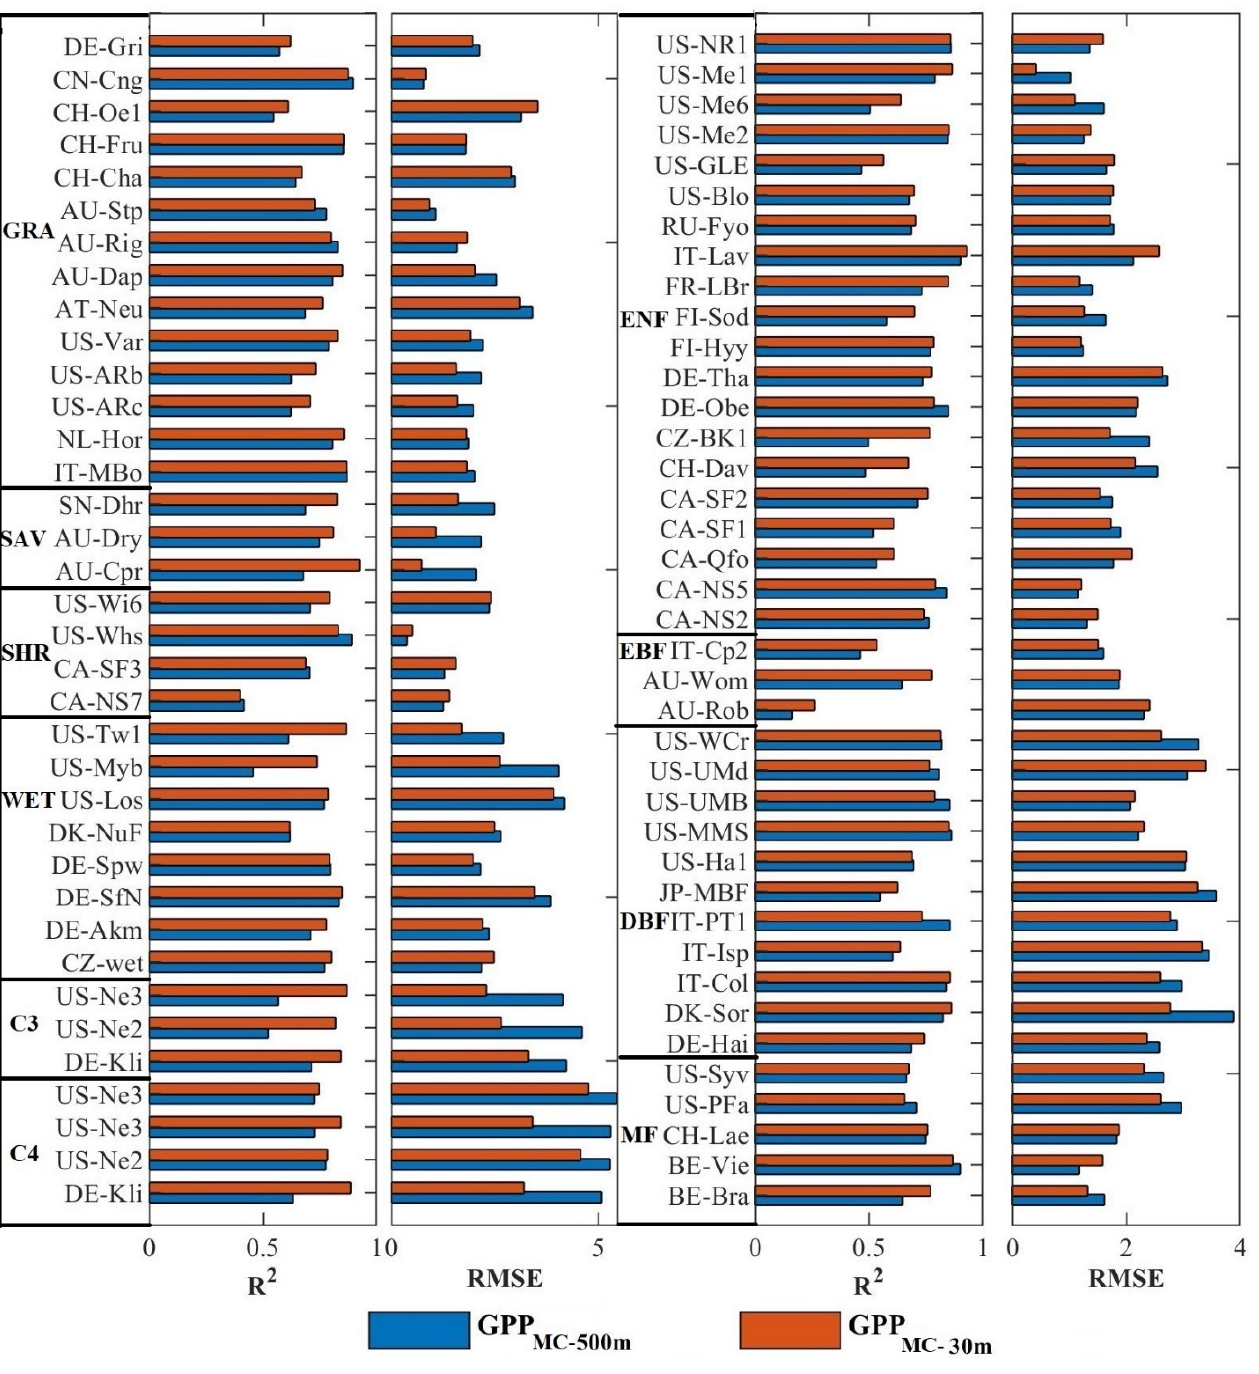
Figure 5. The R 2 and RMSE values for relationships between GPP MC-30m and GPP MC-500m and site GPP (GPP EC ) over 16-day time steps at 78 flux sites.